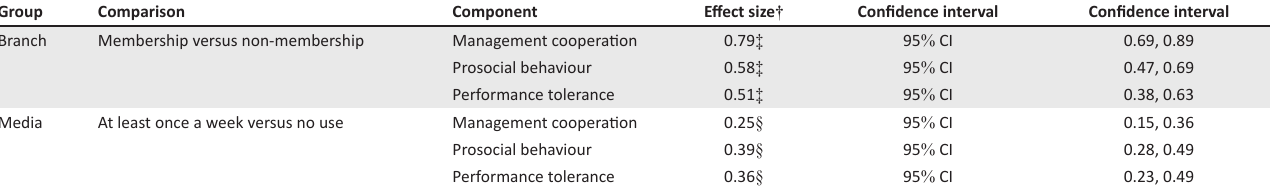
TABLE 8: Mean difference effect sizes with confidence intervals at the 95 % level.